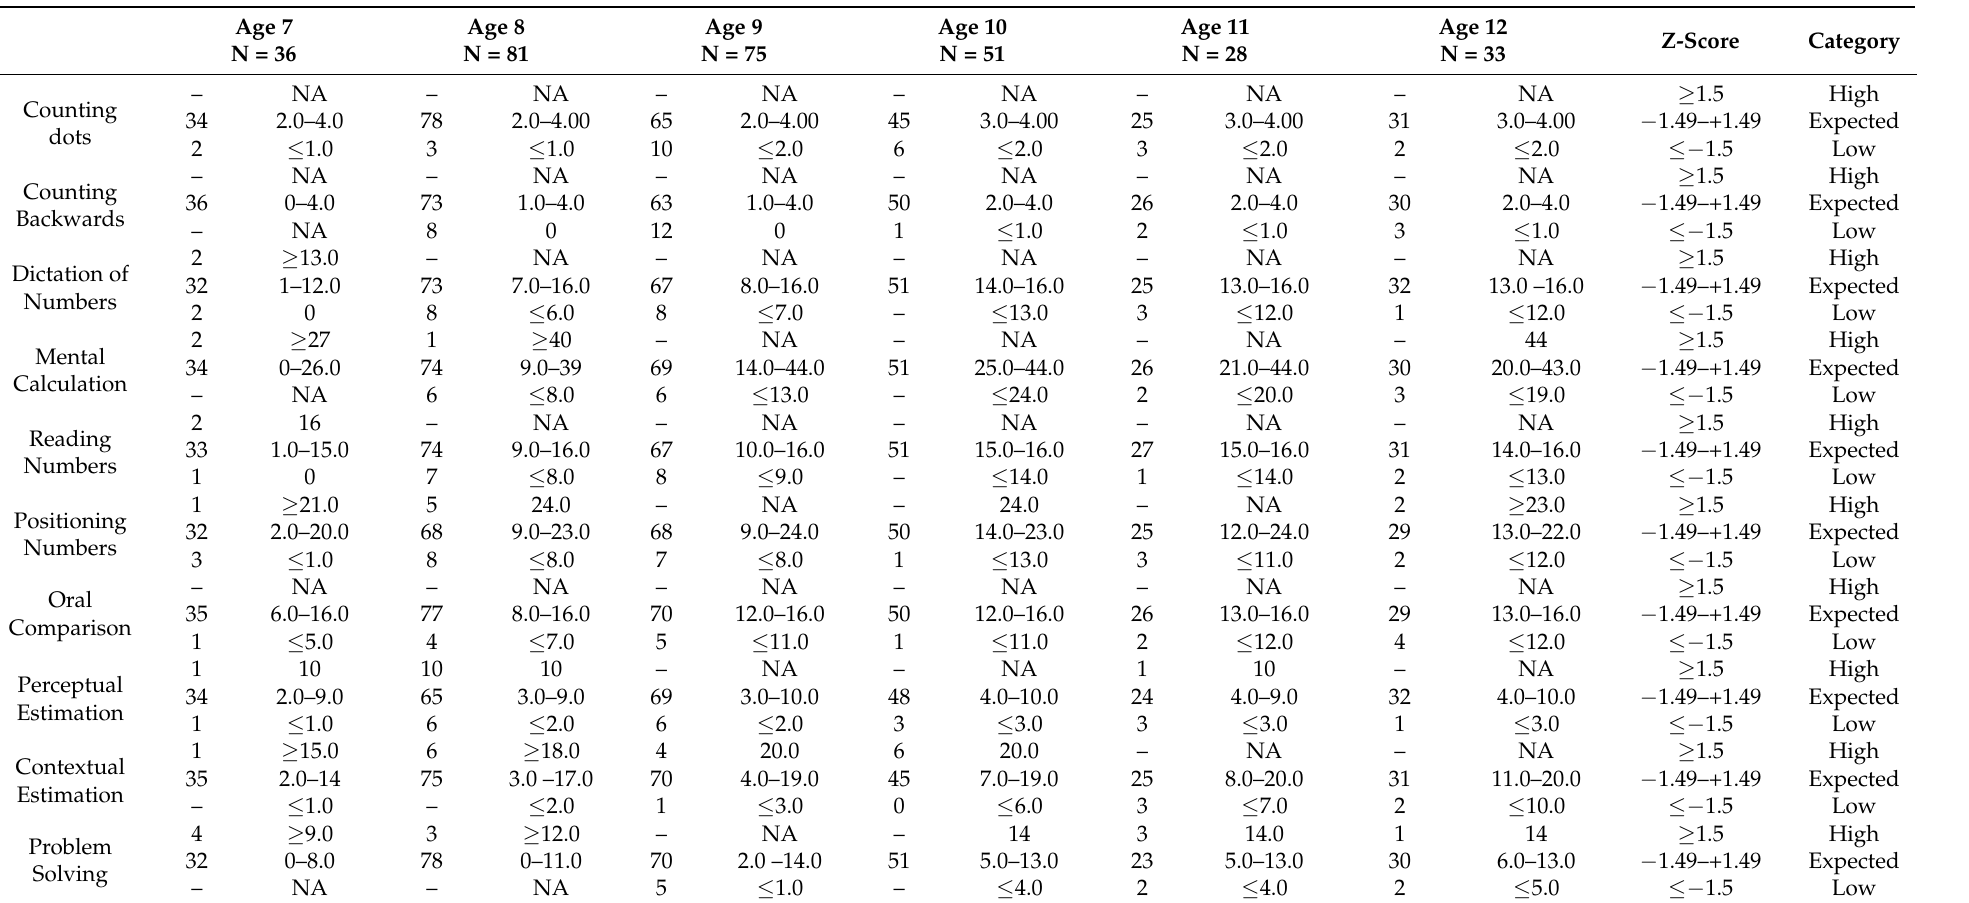
Table A1. Range of raw score results for Zareki-R subtests and total, number of students for each per Z-score, and classification by age